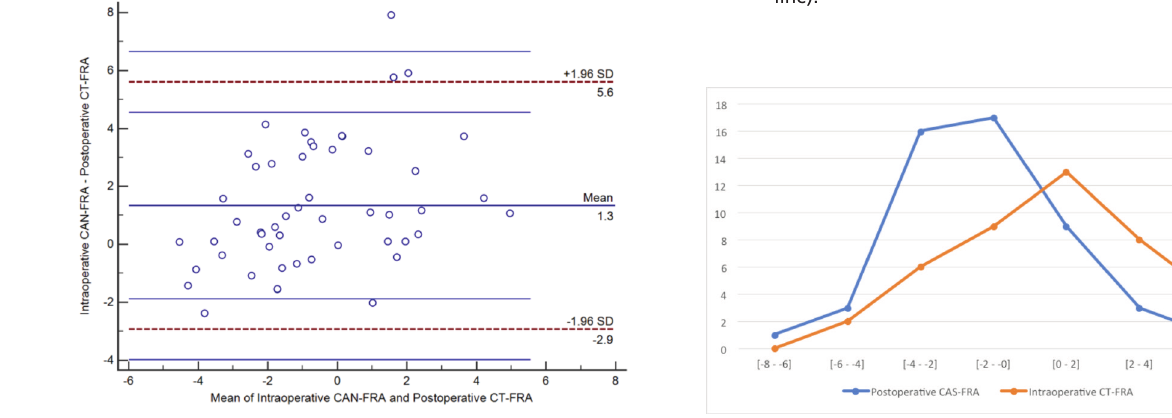
Graph showing the Bland-Altman plot of the mean Fig. 3: difference between the intra-operative computer- assisted navigation data (CAN-FRA) and post-operative computed tomography measurements (CT-FRA).